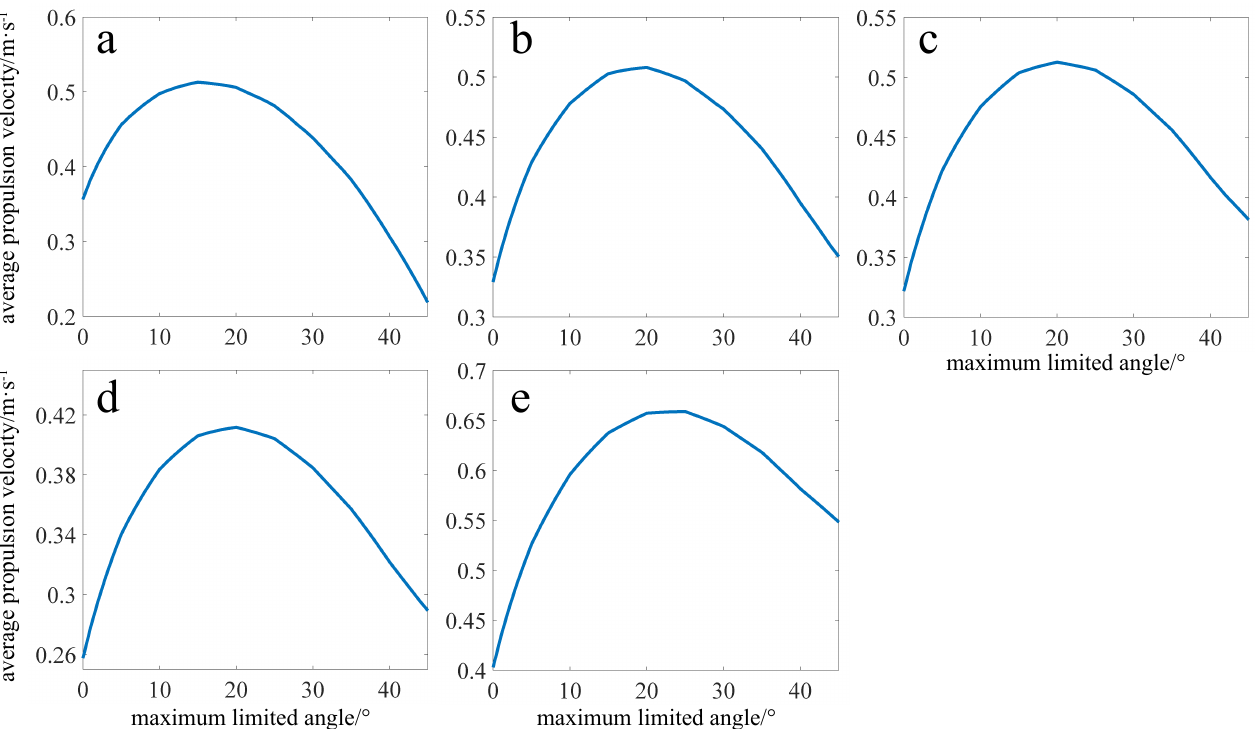
Figure 8. Variation in the average propulsion velocity with the maximum limited angle: ( a ) first type, ( b ) second type, ( c ) third type, ( d ) fourth type, and ( e ) fifth